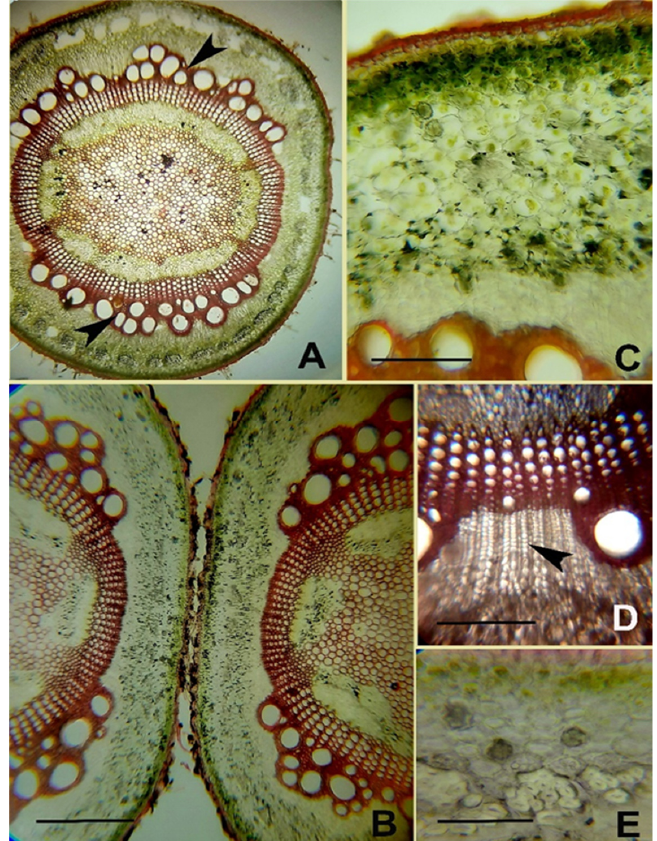
Figure 4. A. Abnormally behaving patches of cambium at opposite sides (white arrow) and normal cambial cells producing secondary xylem towards inside (Black arrow), B. Stem developing rectangular shape and parallelly placed sister branches coming closer for twining at their broader sides, C. Wavy outline of secondary xylem and vessel bordering the phloem wedge. D. Wedge shaped secondary phloem, E. Inner cortex with gelatinous fibres and crystals of Calcium oxalate. Scale bar: 400 µ (B), and 100µ (C, D,